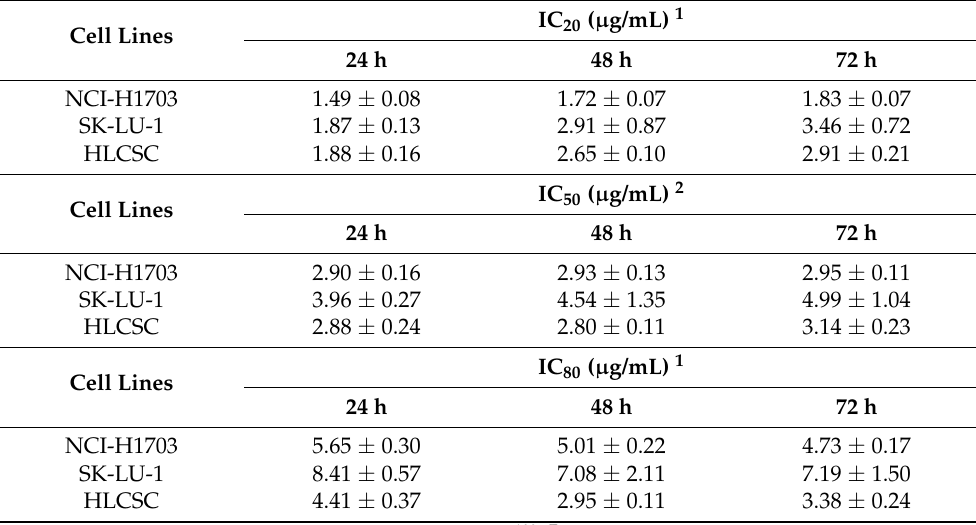
Table 3. IC 20 , IC 50 and IC 80 values of